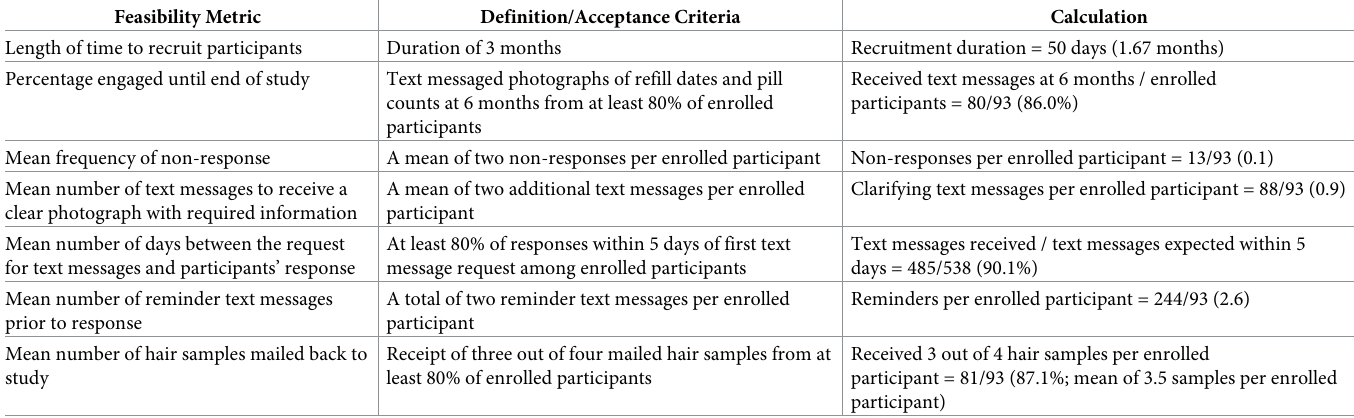
Table 3. Pre-specified feasibility